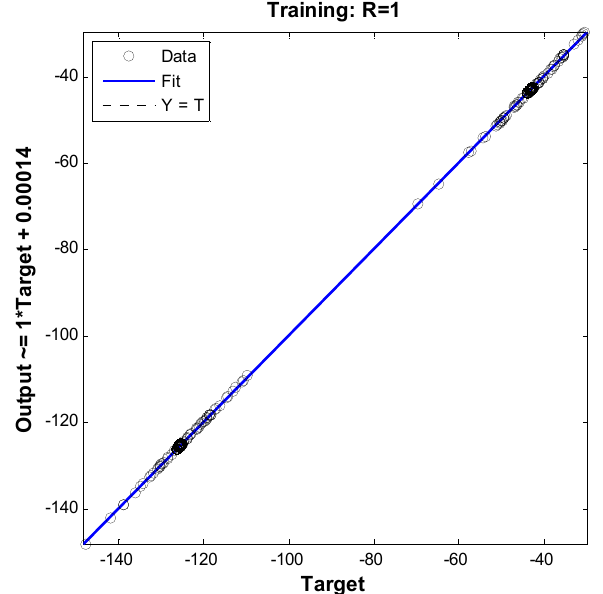
Figure 7. Training plot.